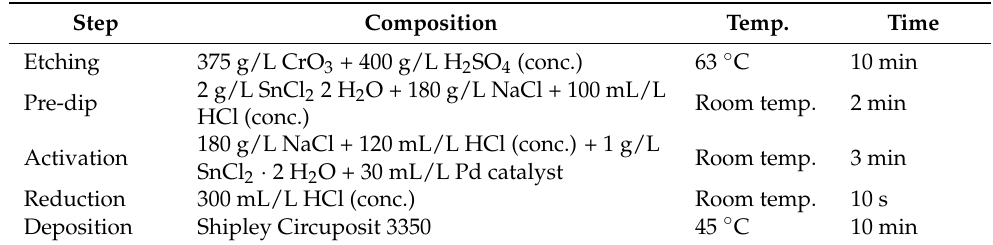
Table 1. Agents used for electroless copper deposition [9].